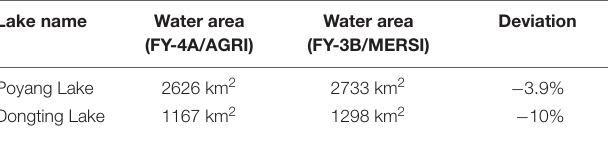
TABLE 4 | Performance comparison between FY-4A/AGRI and FY-3B/MERSI for Dongting Lake and Poyang Lake